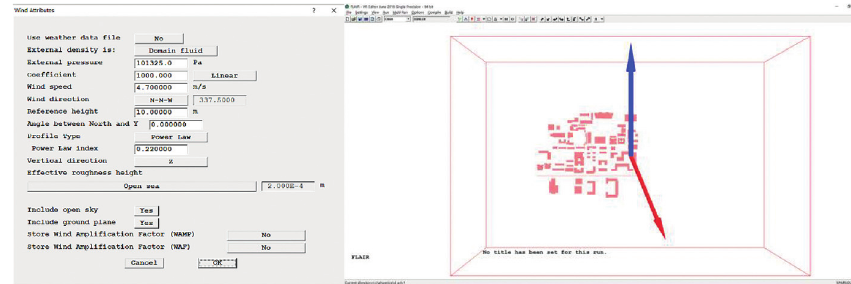
Figure 9: Wind attributes in winter.